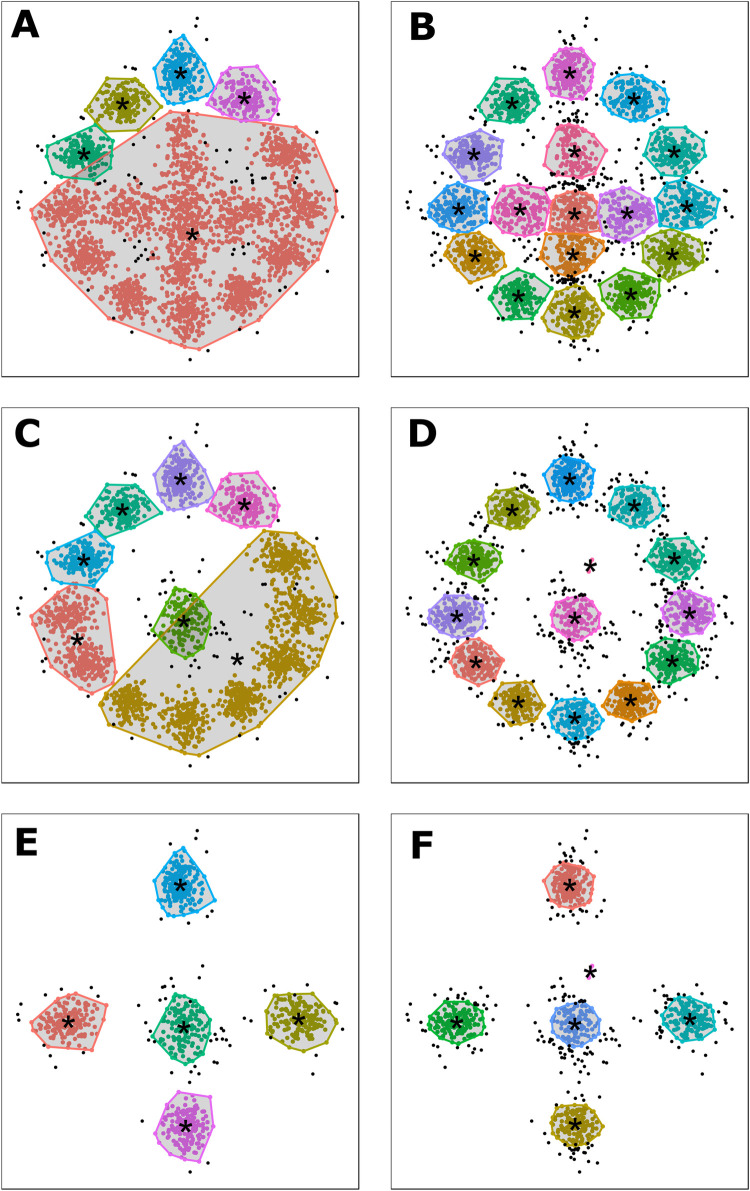
Unsupervised DBSCAN (A, C, E) and MS (B, D, F) pattern recognition results trained on fully superimposed landmark coordinates. Detected clusters are marked by their corresponding colours and calculated convex hulls. Points classified as noise are marked in black. The centroid or point of interest for each cluster is marked by a single black *. (A, B) LM1-17; (C, D) LM1-13; (E, F) LM1-5.